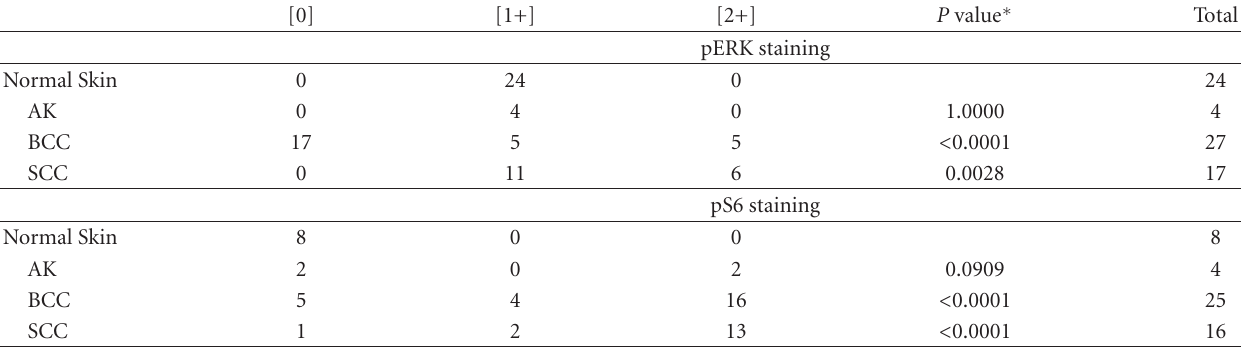
Table 2: Summary of pERK and pS6 IHC staining in normal (noncancer), AK, BCC, and SCC skin